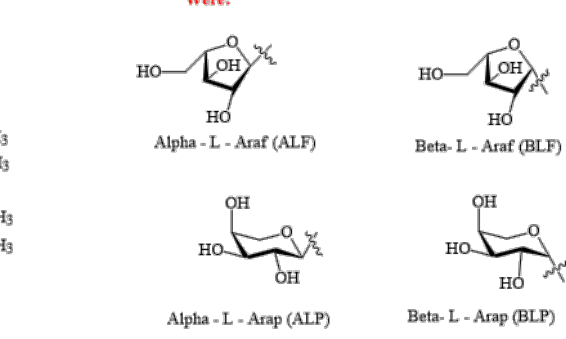
Figure 10. C 19 -glycosides DAs.